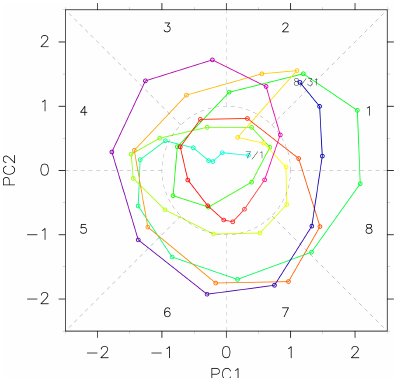
Figure 9. The definition of eight phases based on two normalized leading principal components. The daily phase progress in the year 2016 is shown as an